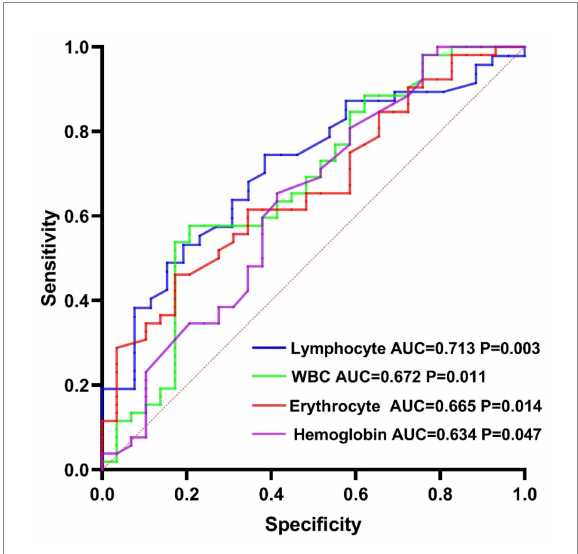
FIGURE 1 Diagnostic and predictive value of serological markers for vascular cognitive impairment in the mild white matter hyperintensity